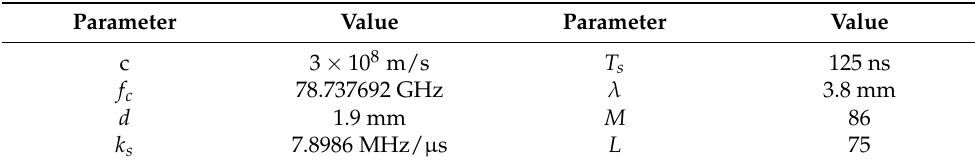
Table 3. TI Cascade FMCW MIMO Radar